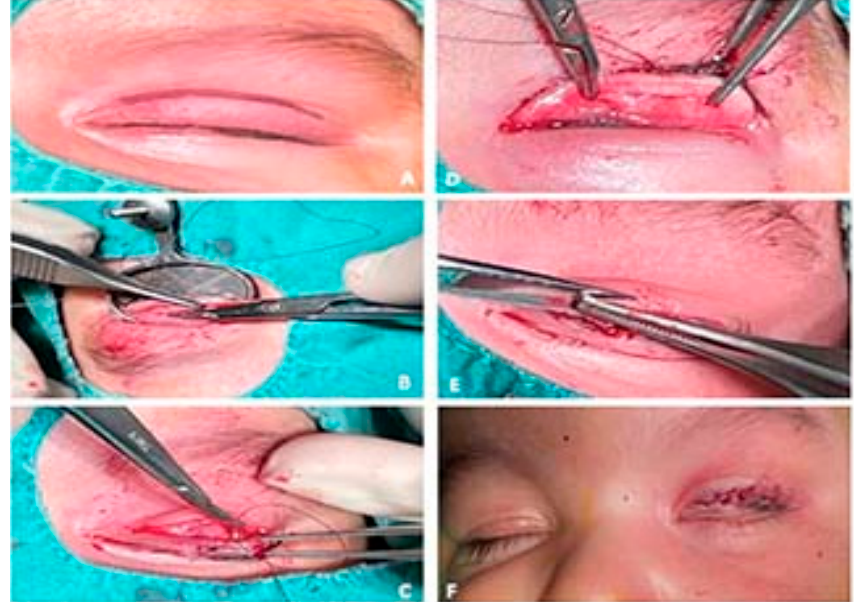
Figure 3. Main surgery steps. ( A ) Marking the incision 5 mm above the free eyelid edge; ( B ) The excision of the fibrous band on the entire length and width of the tarsal plate; ( C , D ) Application of sutures on the trajectory: skin (ciliary margin)—upper tarsal plate—skin (ciliary margin) in the inner, median and outer third of the upper eyelid; ( E ) Excision of a hypertrophied orbicular pretarsal muscle extension; ( F ) Cutaneous suture (personal collection).